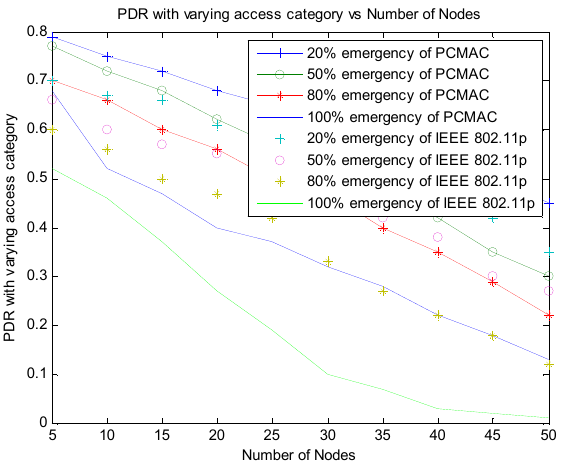
Figure 12. Comparison of PDR of PCMAC and IEEE 802.11p with varying emergency packets.